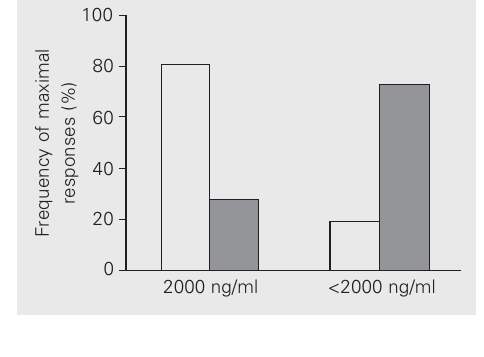
Figure 1. Tumor necrosis factor alpha (TNF- α ) production in un- stimulated 24-h whole blood cultures of healthy controls (N = 18) and malnourished children (N = 11). Data are reported as mean ± SEM of TNF- α meas- urements in 24-h culture super- natants. P between groups <0.000 ( t -test).